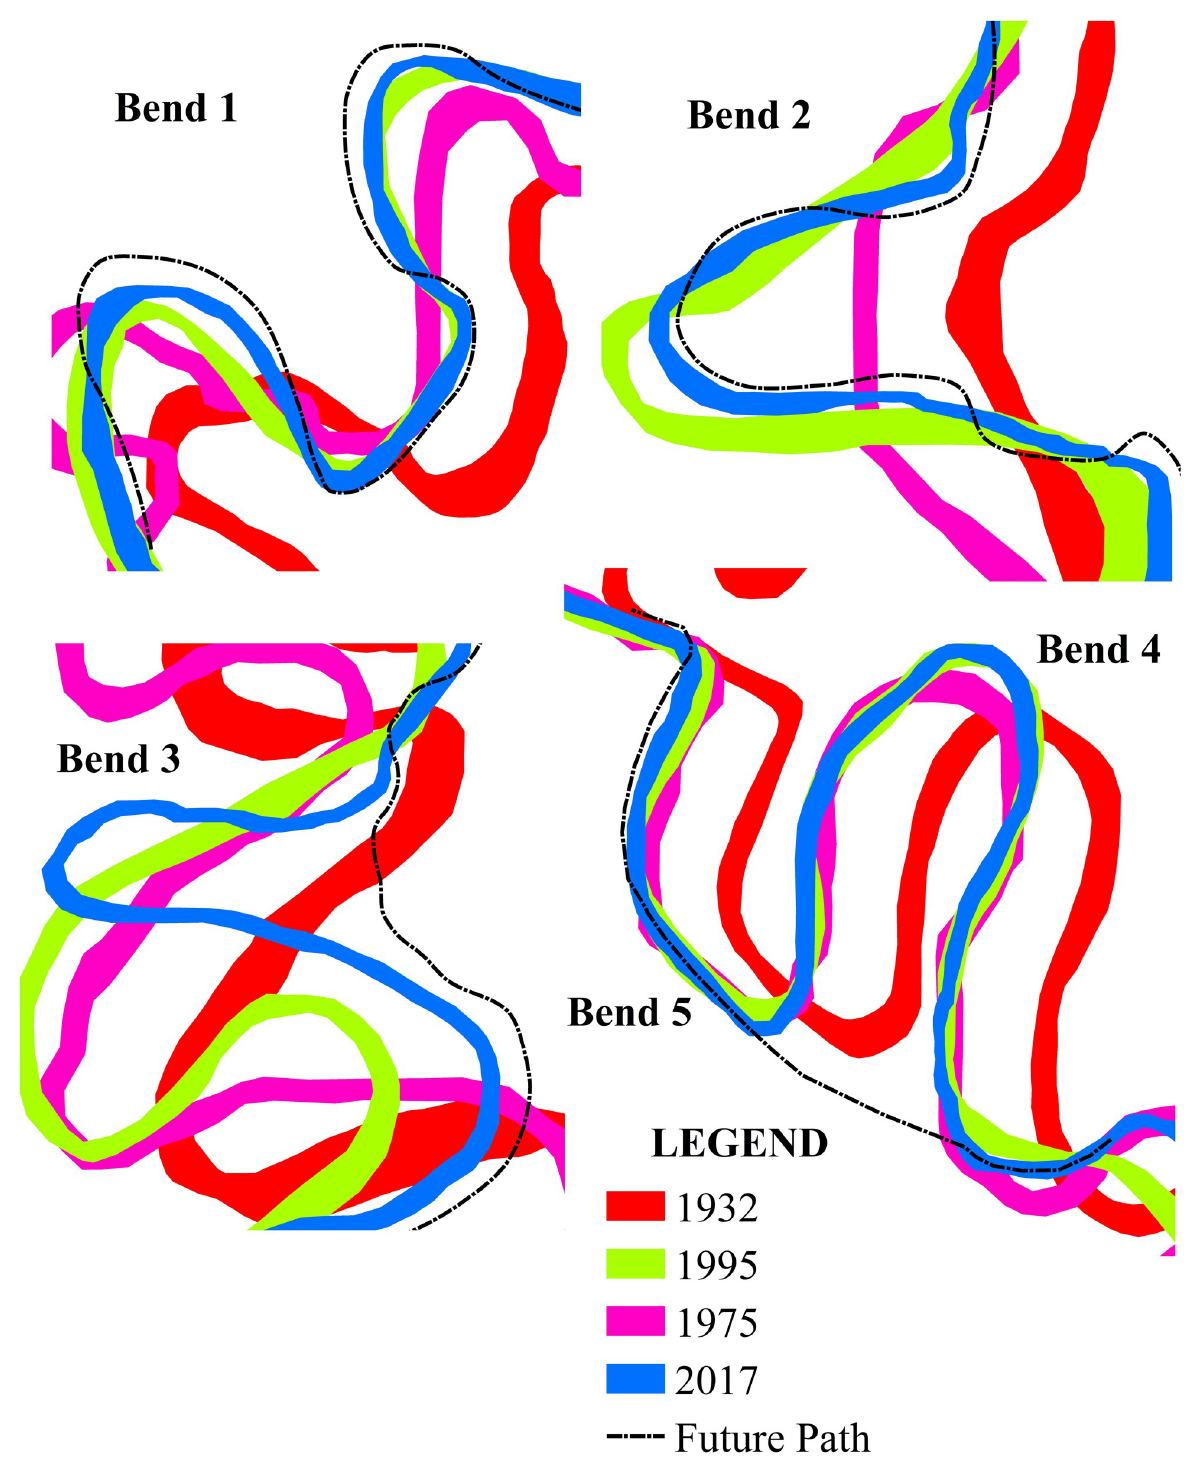
Fig 20. The probable future path of the selected meanders.